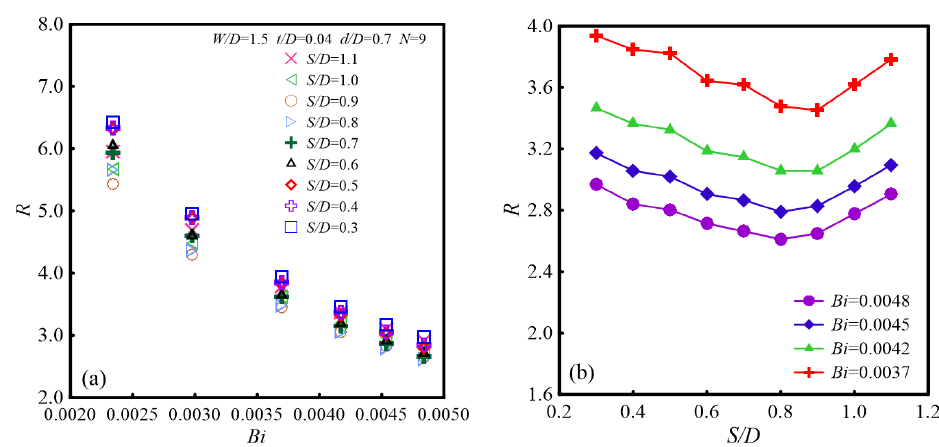
Fig. 11. Influence of geometrical parameter S/D on thermal